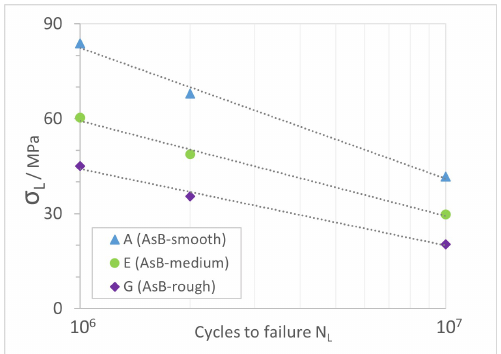
Figure 9. Estimated stress for different endurance limit values N L .